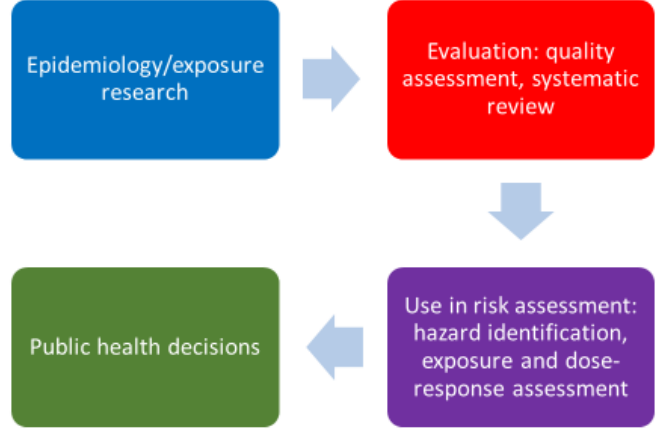
Figure 1. Steps from the completion of an epidemiology study to the development of an environmental health decision.